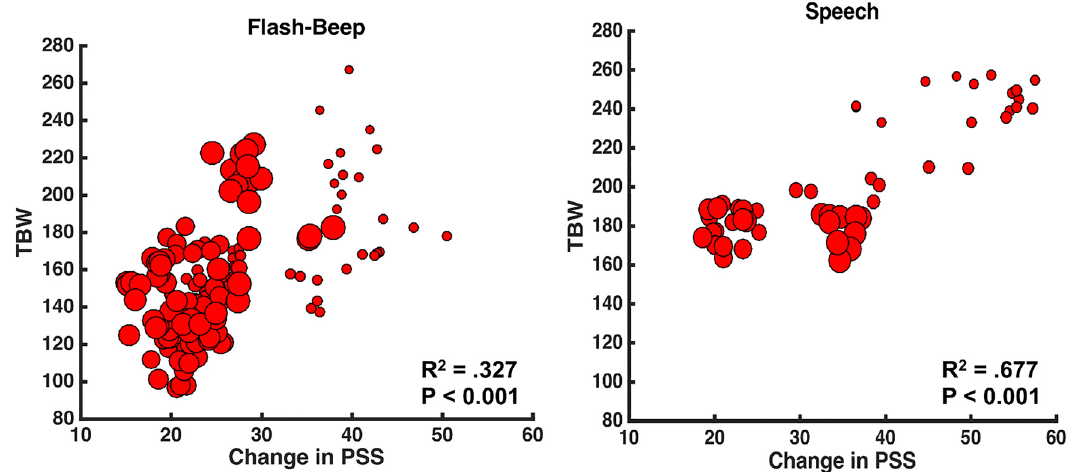
Fig 3. Correlation between the size of participant ’ s TWS and rapid recalibration ( Δ PPS). Left panel demonstrated a significant correlation between TWS and Δ PPS for Flash-Beep stimuli, while right panel demonstrates the same relation for Speech stimuli. The size of the dots indexes age of the participant represented, conveying the fact that these correlations seem to be largely driven by